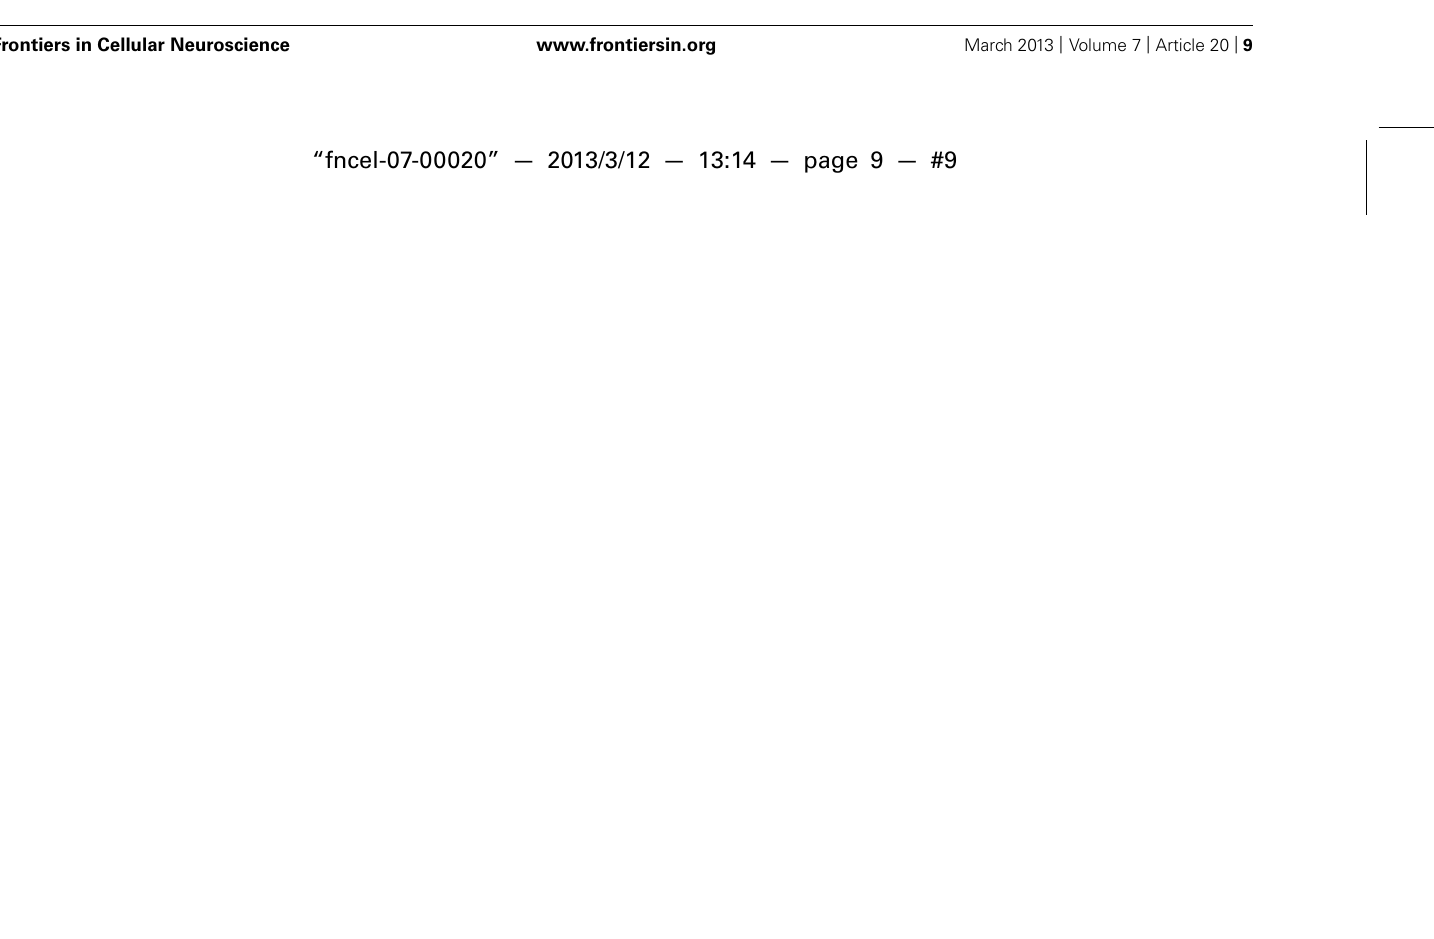
response by 20 μ M bicuculline is shown at the bottom. Corresponding peristimulus spike time histograms normalized to 100 sweeps are shown below each trace. (C) Summary plot of electrically evoked MUA response, normalized to the baseline at the surface and depth of the slice. Squares reflect the normalized MUA response at the depth and the surface of an individual slice, circles show mean values ±